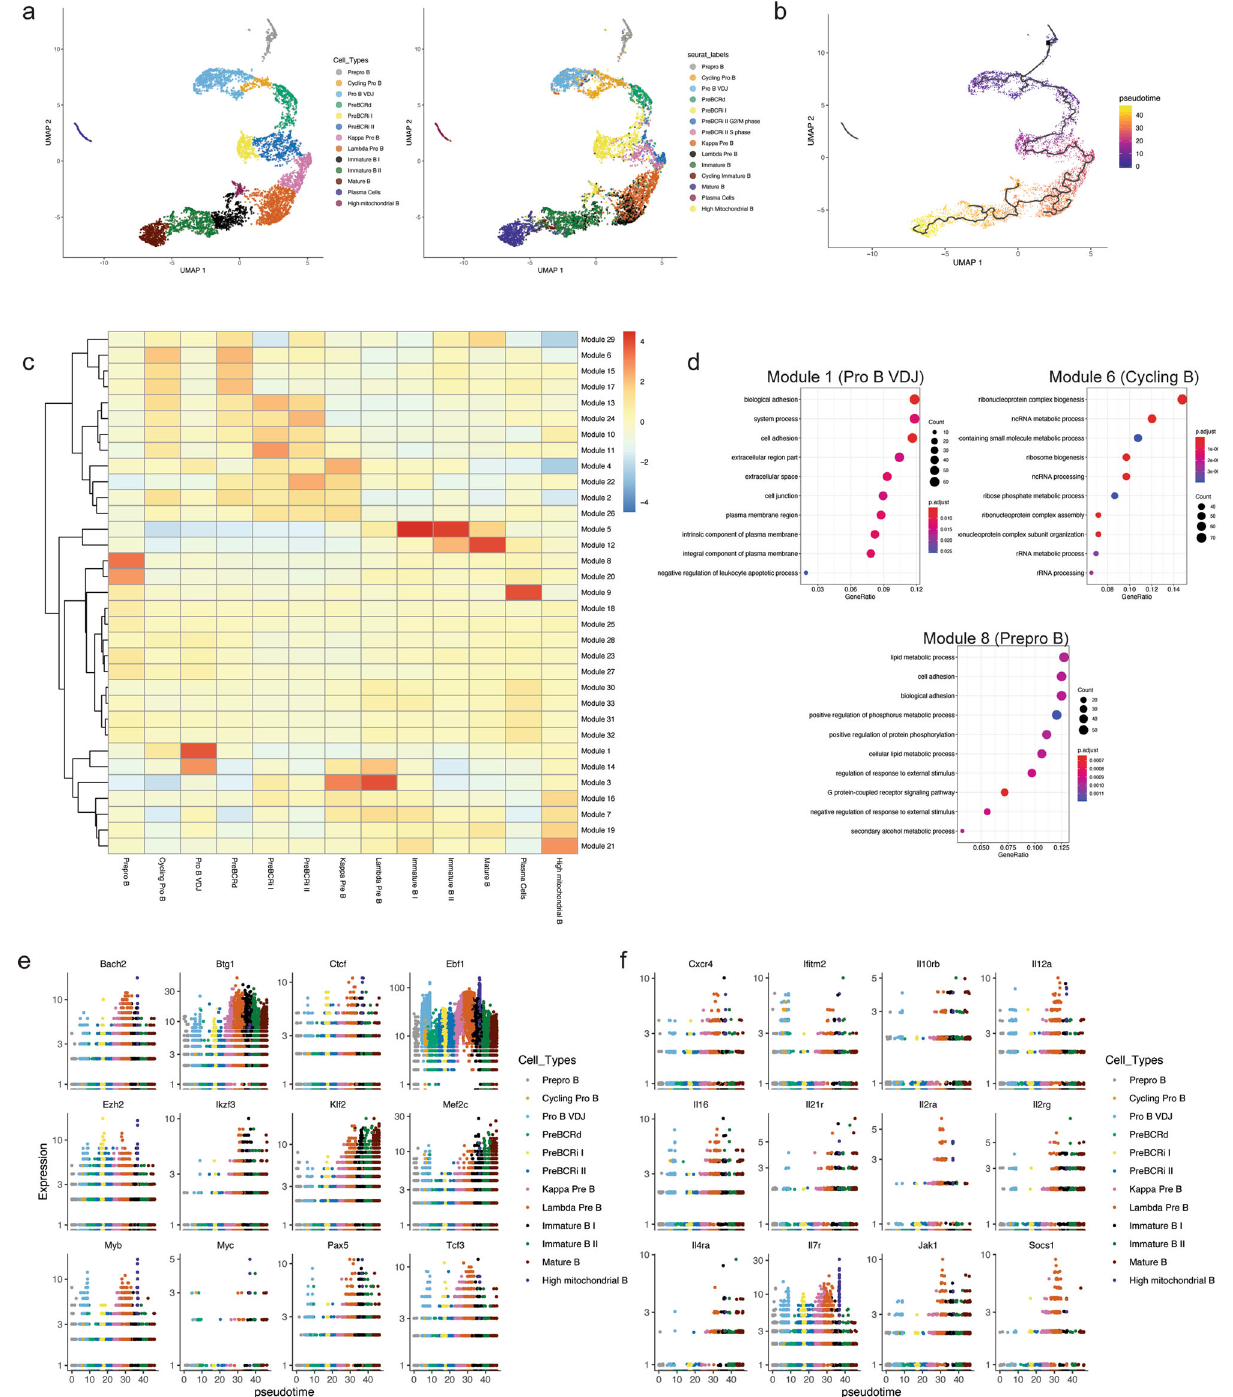
Fig. 6 Pseudotime analysis illustrates the kinetics of transcription-factor expression and gene modules that are differentially expressed across the B-cell development trajectory. a Cell cycle-related genes were regressed within Monocle3 and UMAP dimension reduction was performed. Clustering was performed based on the Monocle3 clusters (left). Cells from Monocle-based clustering labeled with Seurat cluster labels (right). b Pseudotime values were calculated and plotted. c Module analysis to demonstrate gene modules that change across the B-cell developmental trajectory. A total of 33 modules and their expression intensity for each stage are shown. Color scale represents normalized module gene expression. d Gene ontology term analysis of selected modules 1, 6, and 8. e Expression of B-lymphoid transcription factors and epigenetic factors across B-cell development stages. f Expression of cytokine, chemokine and cytokine/chemokine receptors across the B-cell developmental trajectory.